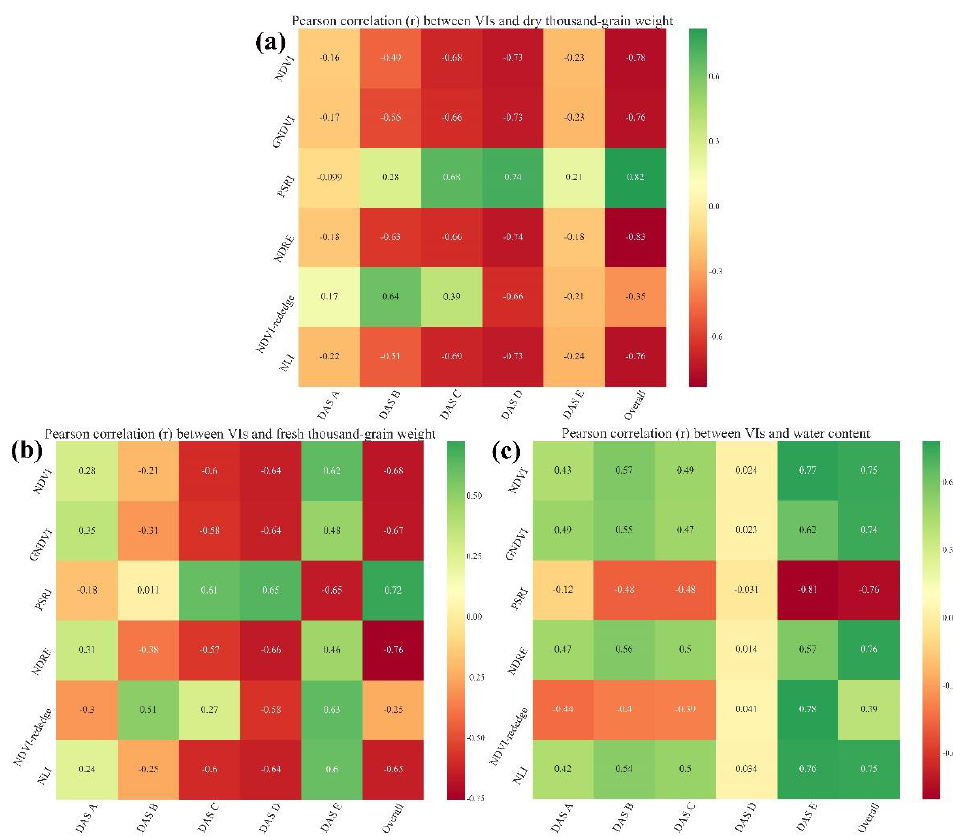
Figure 4. Pearson correlation (r) between vegetation indices (VIs) and three indicators (( a – c ) represent dry thousand-grain weight, fresh thousand-grain weight and water content, respectively) of wheat grain-filling process by days after sowing and overall. A – E represent five sampling periods.